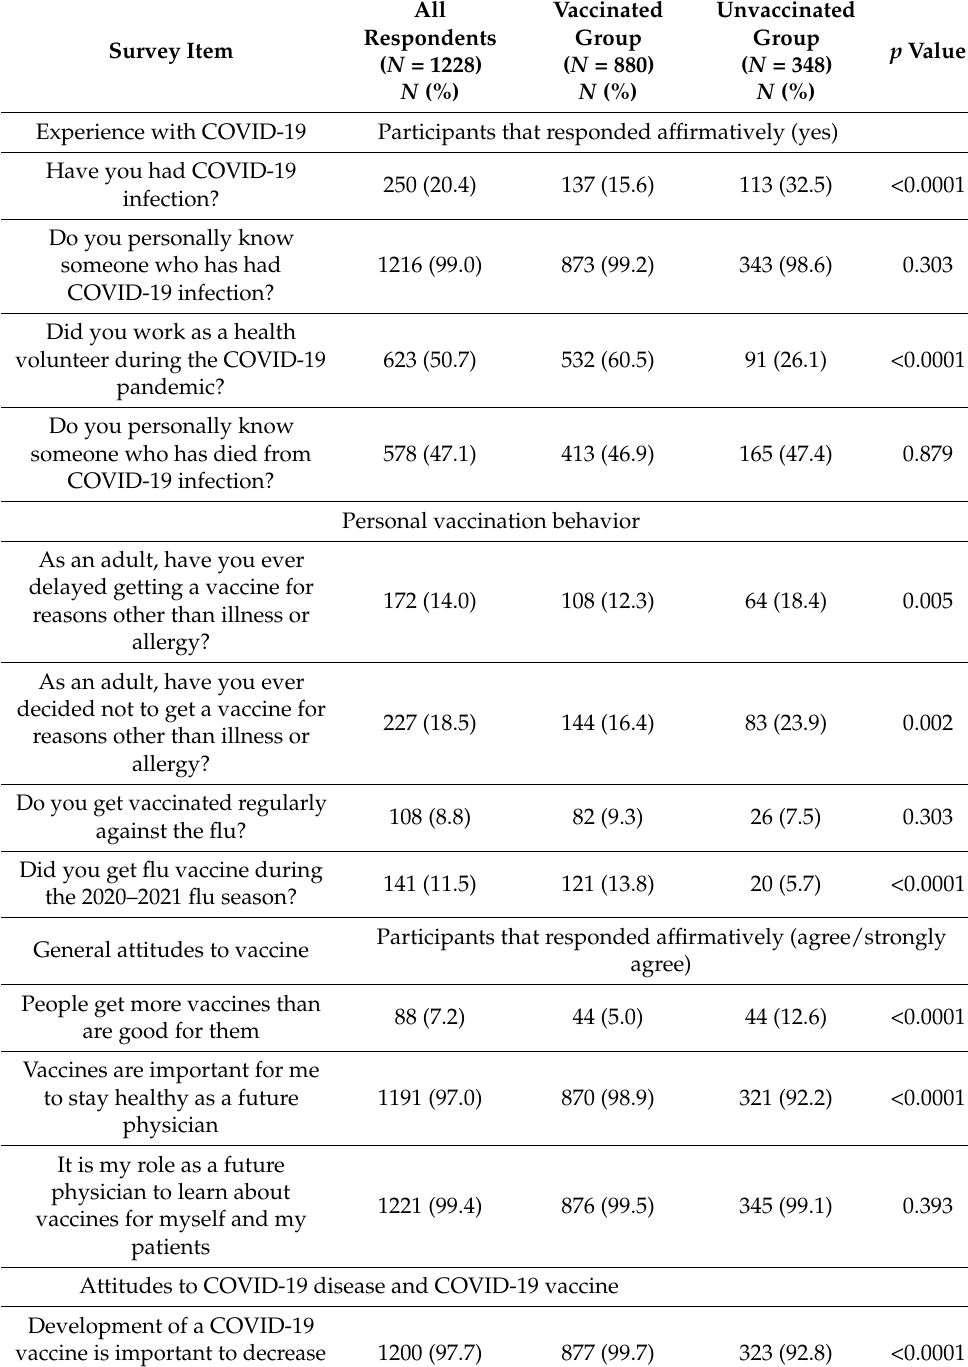
Table 2. Survey responses among COVID-19 vaccinated and unvaccinated groups. Univariate analysis.